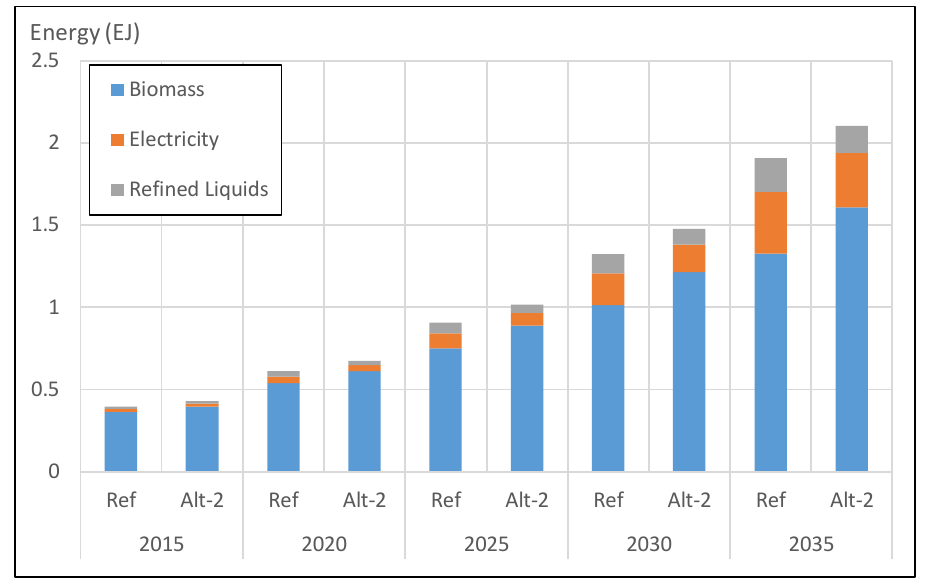
Figure 9. Comparison of Energy Demand in the Building Sector due to Biomass Efficiency Improvement, Ref. vs. Alt-2 Scenario (Unit: EJ).